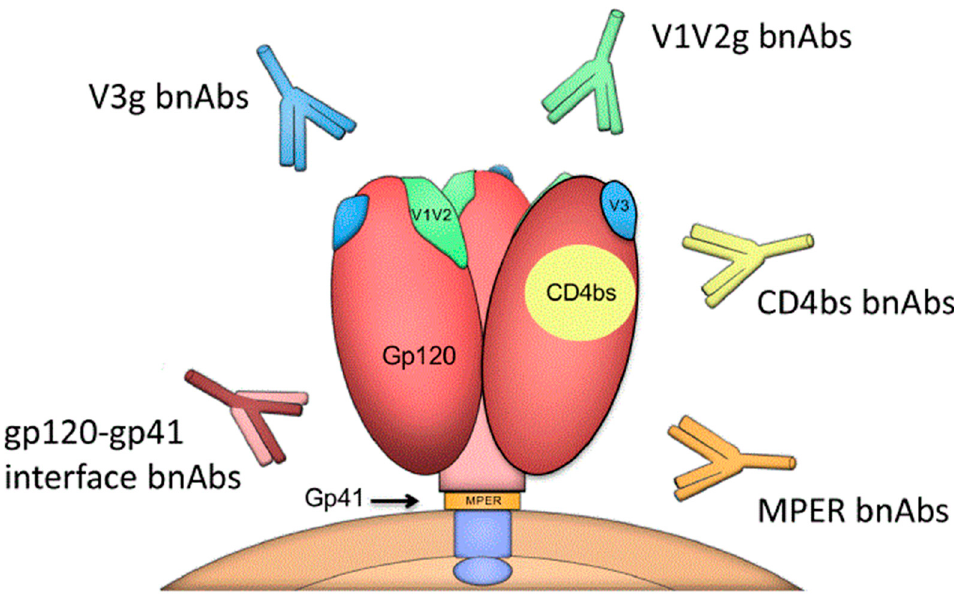
Figure 1. Sites of vulnerability on the HIV-1 envelope (Env) trimer and broadly neutralizing antibodies (bnAb) classes.